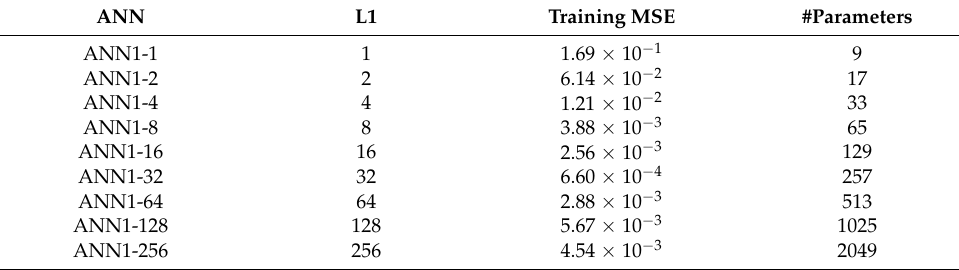
Table A3. Single-layer ANN training results